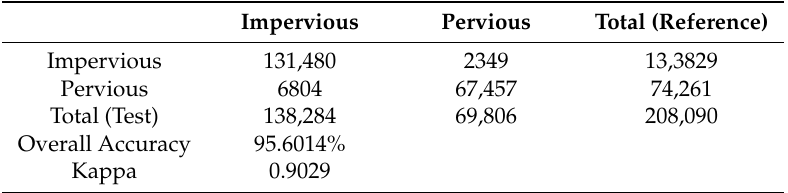
Table 8. Confusion matrix and accuracy of the impervious surface distribution